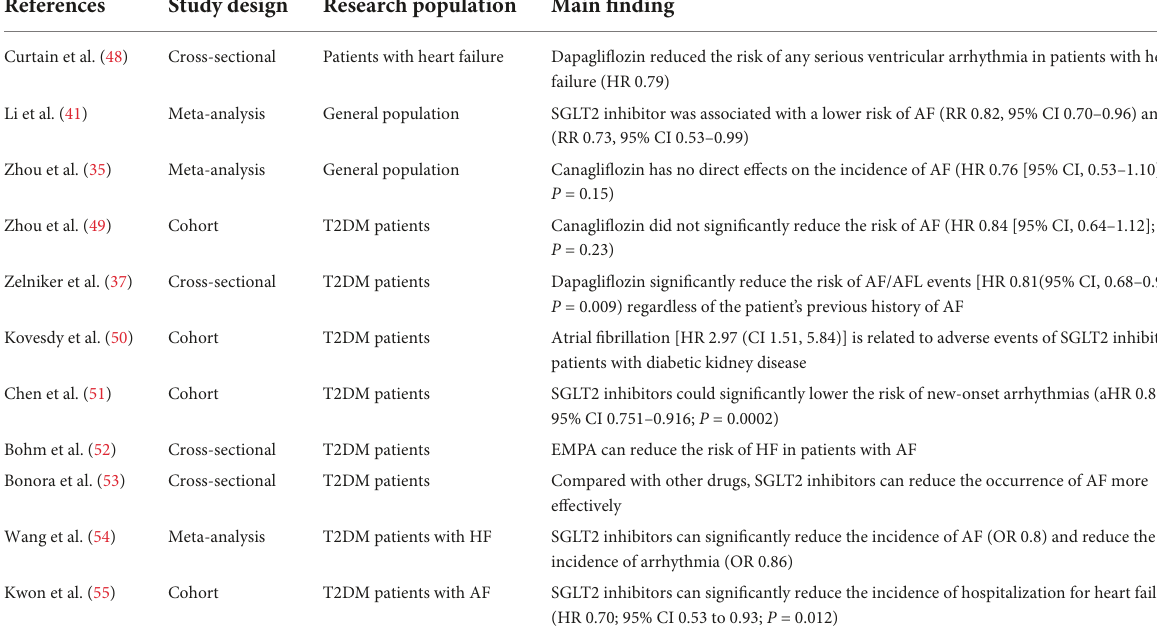
TABLE 1 The impact of SGLT2 inhibitors on the risk of arrhythmias.